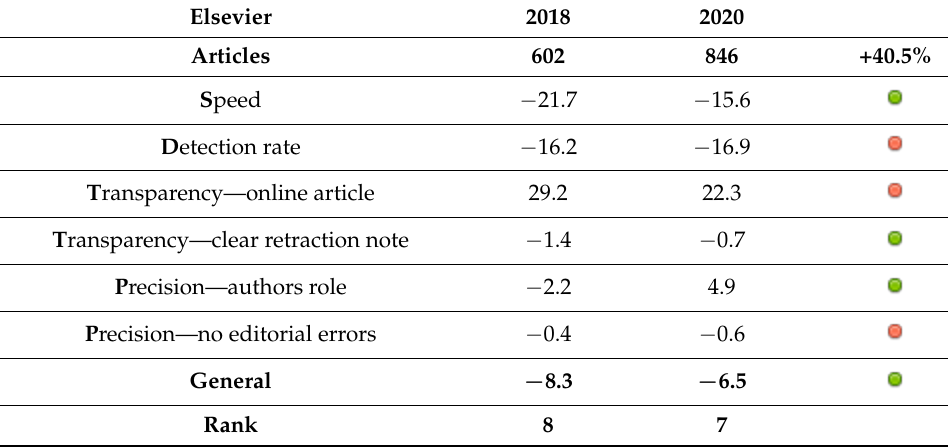
Table 15. Elsevier 2018–2020 change of SDTP score.